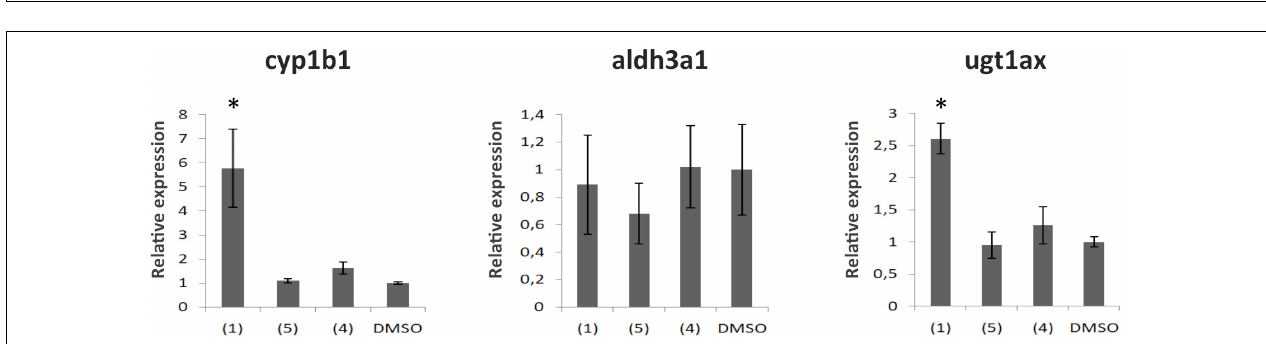
FIGURE 6 | Molecular modeling suggests that compounds 1 and 2 can bind to the AHR. (A) Homology model of the PAS-B domain of human AHR in complex with a dibenzofuran derivative (orange C and red O spheres). (B) Close-up view of the internal cavity of the AHR model, illustrating a bound conformation of 2 and the surrounding hydrophobic residues (cyan C, blue N, yellow S). The asterisk indicates position-1 of the dibenzofuran ring.